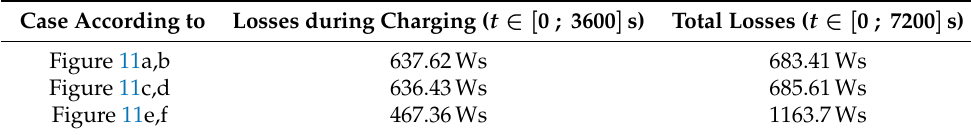
Table 4. Ohmic losses (energy) during the charging and relaxation phases for the different variants of the reinforcement learning control